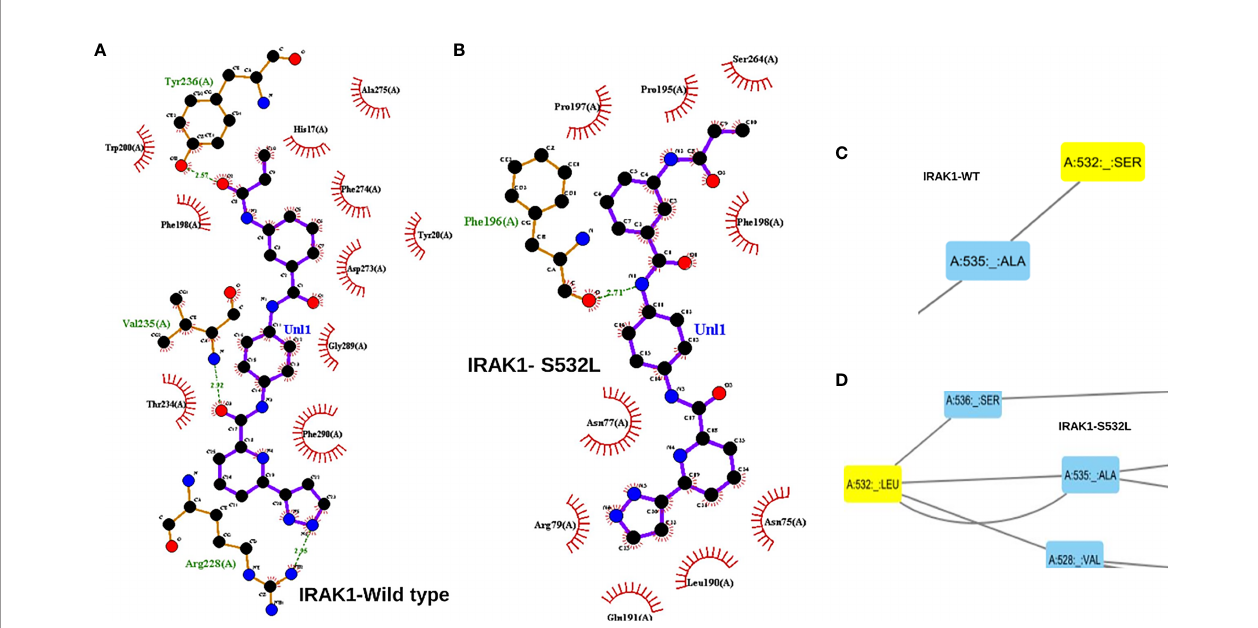
FIGURE 5 | (A) A ligplot interaction image showing the interaction of JH-X-119-01 an IRAK1 inhibitor interacting with 3 residues of the wild type IRAK1 molecule. (B) Ligplot interaction image showing the interaction of JH-X-119-01 with just one residue of the S532L mutant IRAK1 molecule. The interactions in a and b have been marked in red circles. (C) A cytoscape screen shot showing the interaction of just two residues within the IRAK1 wildtype molecule. (D) Cytoscape screen shot showing increased interaction of 4 residues within the S532L mutant IRAK1 molecule.